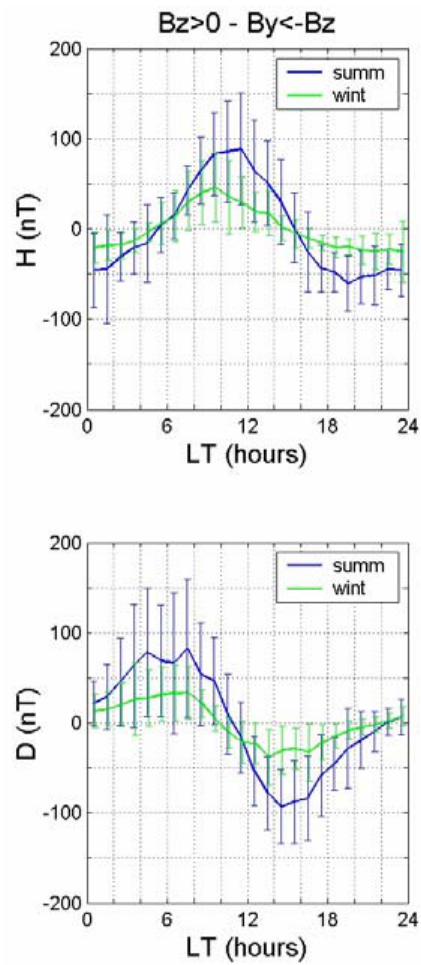
Fig. 7. Daily distribution of the average hourly values and their stan- dard deviation for the H and D components, for B z > 0 and B y < – B z , separately for summer and winter Figure 7. Daily distribution of the average hourly values and their standard deviation for the H and D components, for B >0 and B <-B , separately for summer and winter seasons. z y z